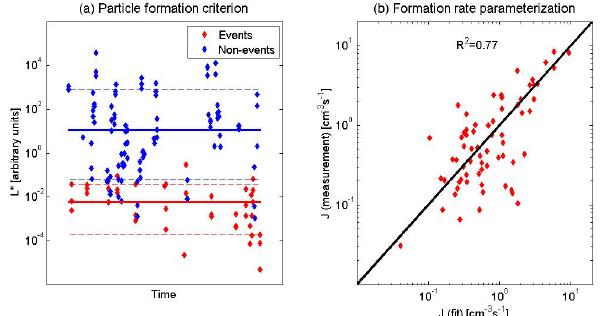
Fig. 9. Description of central particle formation characteristics as a function of observations of radiation, condensational sink, rela- tive humidity, and SO 2 concentration. See respective sections for equations. (a) Particle formation criterion with quartiles. Note that the upper and lower quartile for events and non-events, respectively, do not overlap. (b) Particle formation rate J 6 parameterization with best fit. R 2 = 0 .